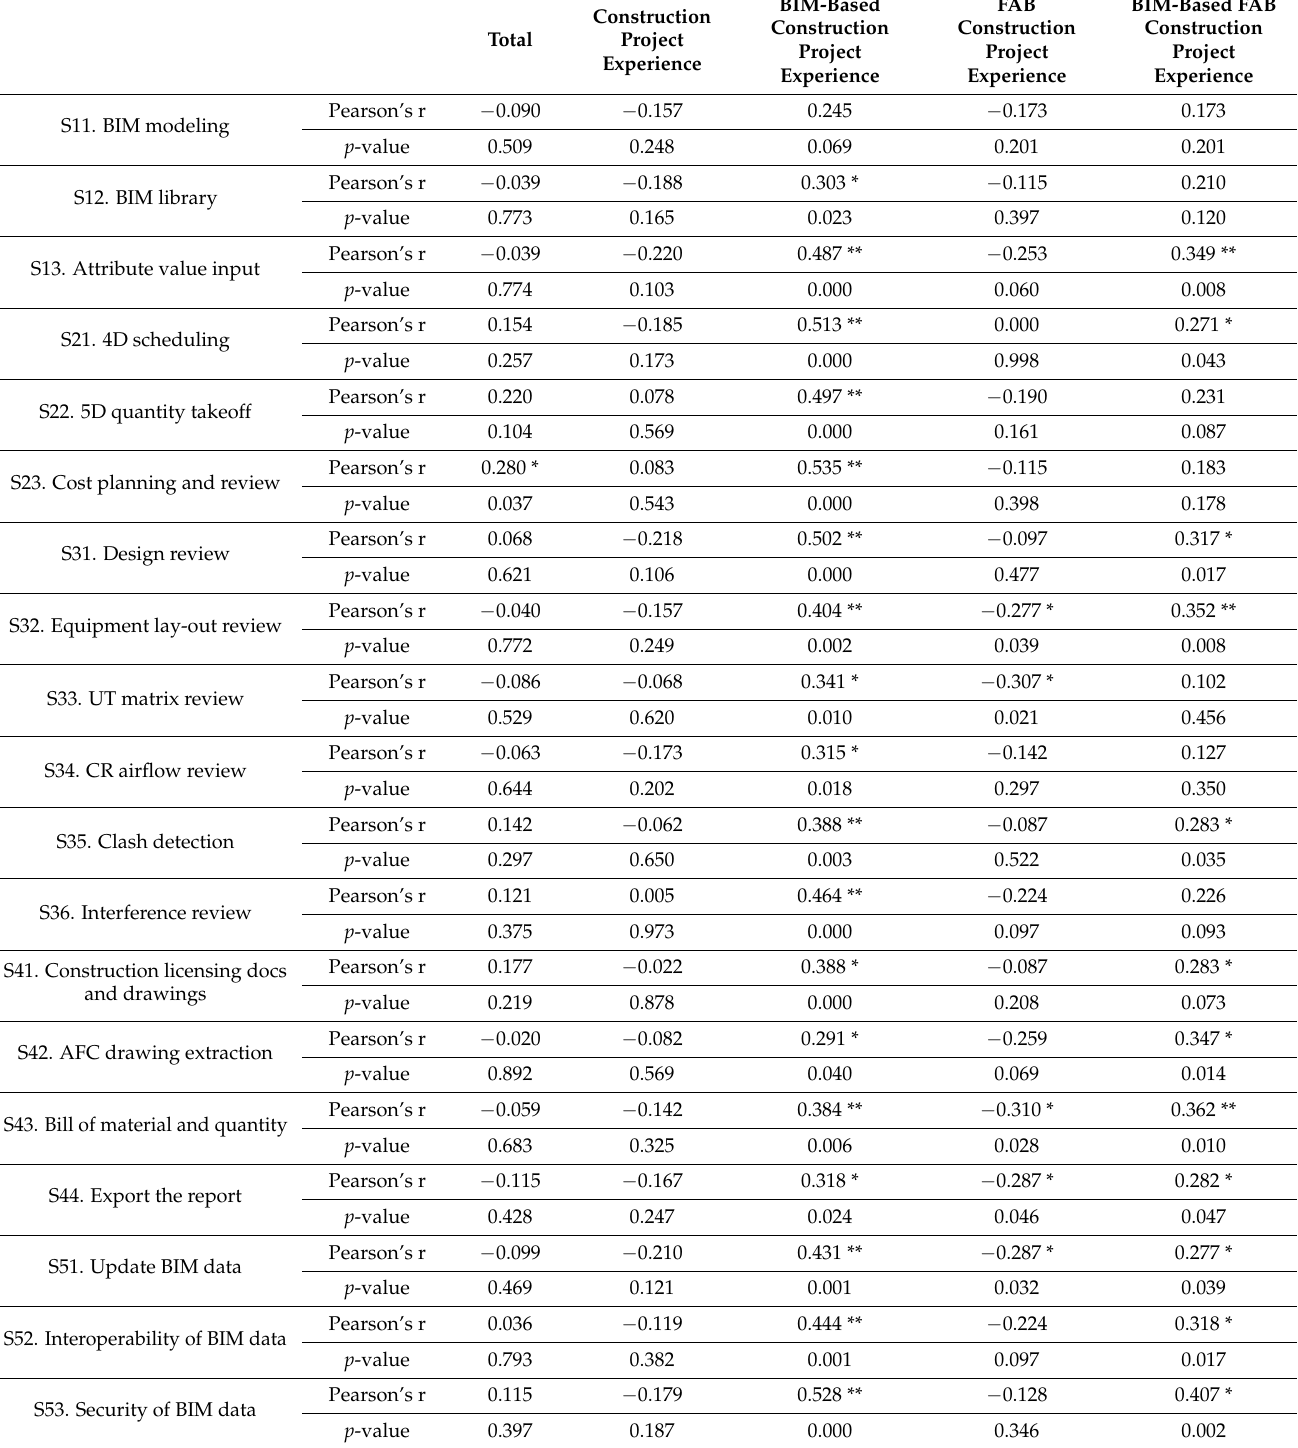
Table 10. Analysis of correlation between ‘Skills’ domain competencies and career characteristics of the designer